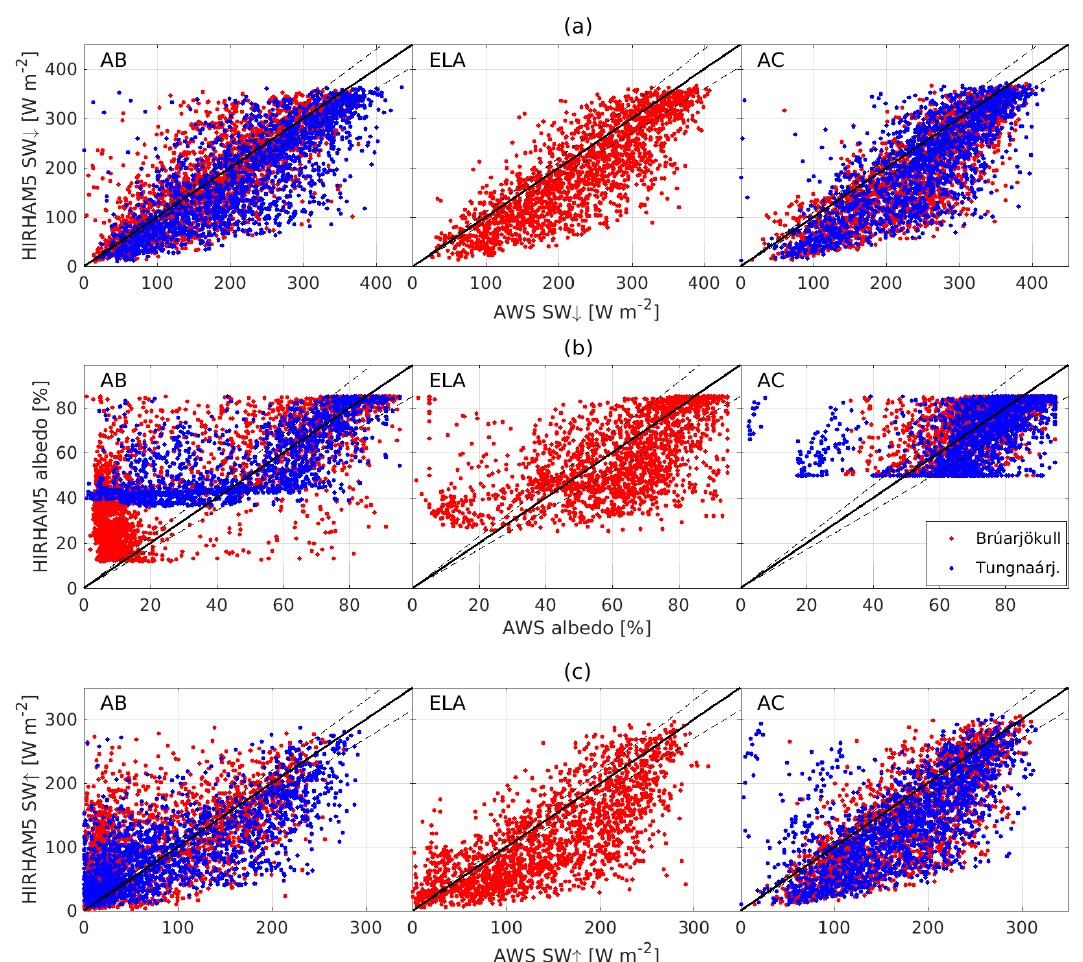
Figure 4. Scatter plots of the measured shortwave radiation components, (a) SW ↓ , (b) albedo, and (c) SW ↑ , by stations on Bruarjökull (red) and Tungnaárjökull (blue) versus the shortwave radiation components simulated by HIRHAM5 at the same locations. The dashed line corresponds to the uncertainty of the measured AWS components.